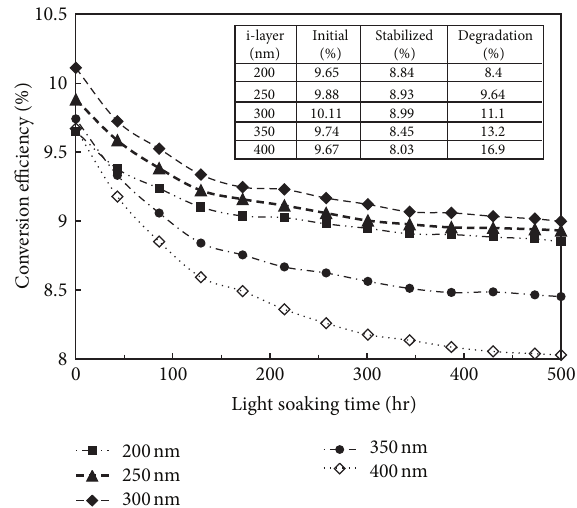
Figure 5: The total generation and recombination of solar cells with different i-layer thickness. The inset of Figure 6 shows the calculation result of the net charge carrier density for each i-layer thickness.